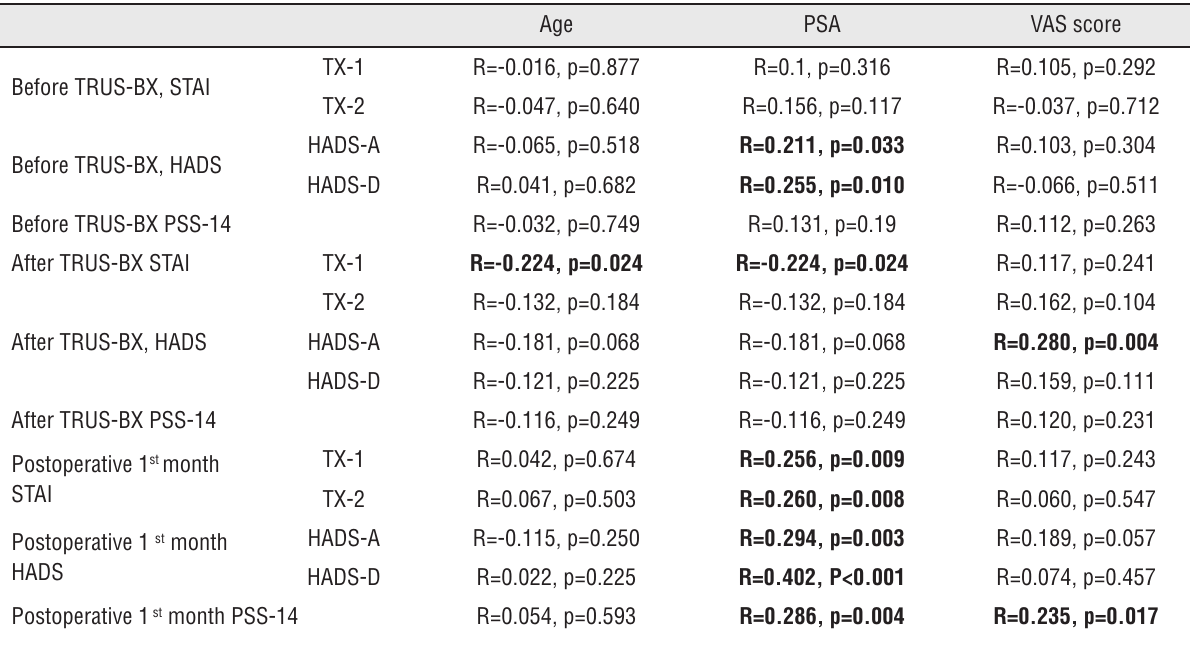
Table 2 - Correlation results between the questionnaire scores and the age and PSA